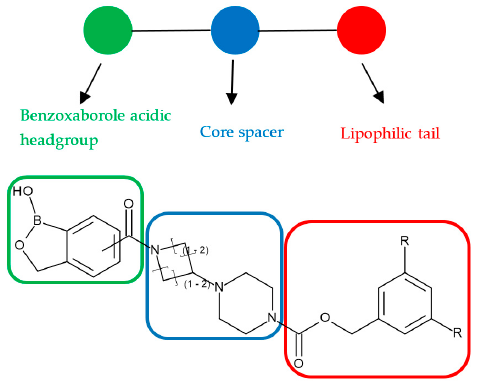
Figure 4. General structure of novel ATX inhibitors.